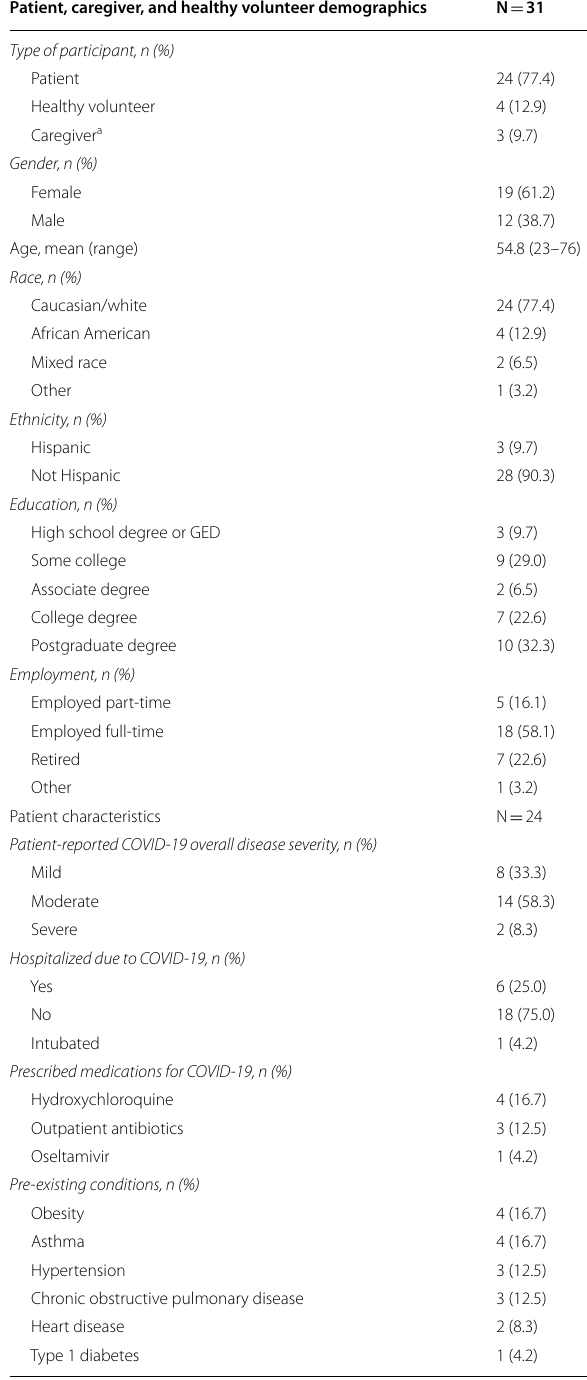
Table 2 Patient, caregiver, and healthy volunteer demographics and